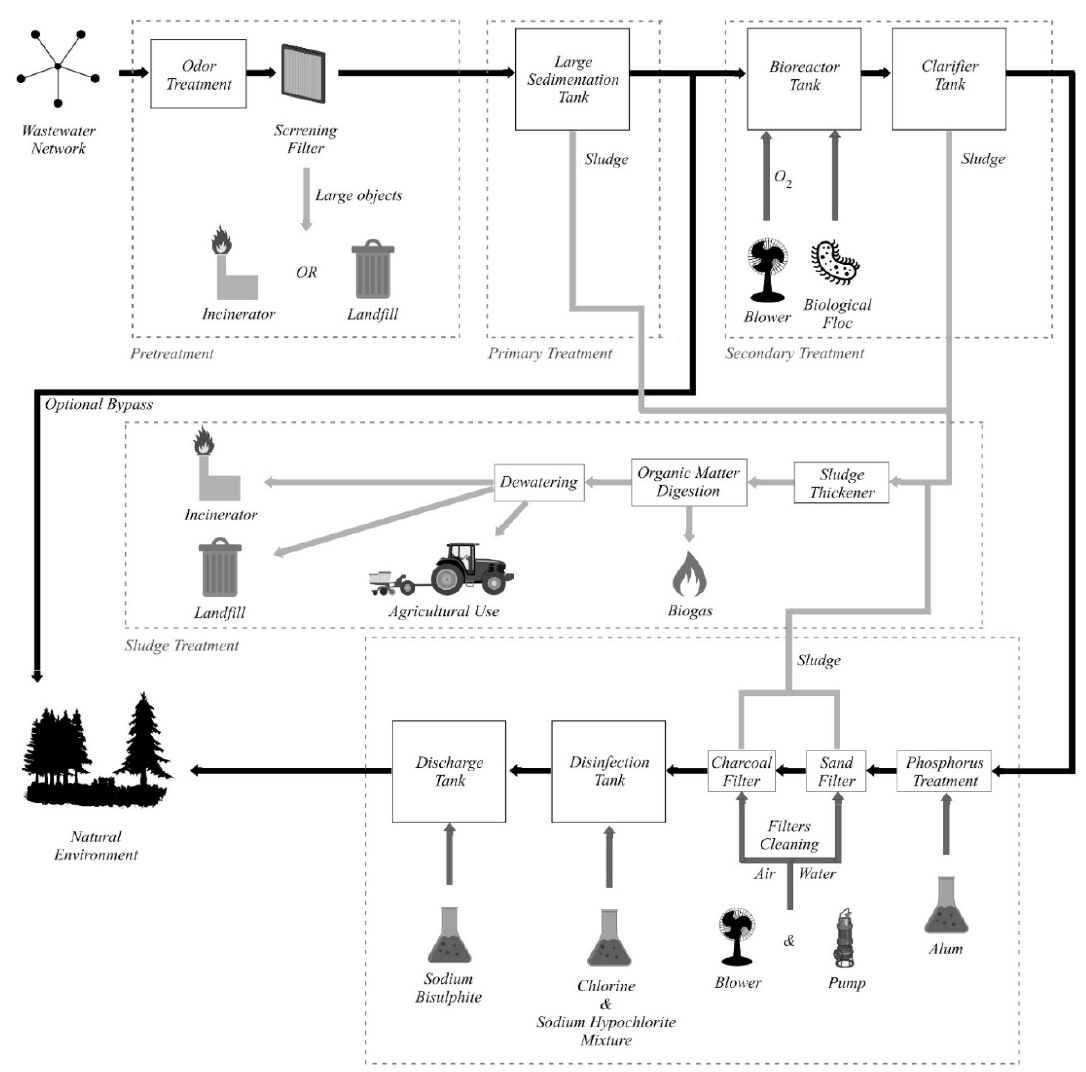
Figure 1. Typical wastewater treatment plant (WWTP) processes.